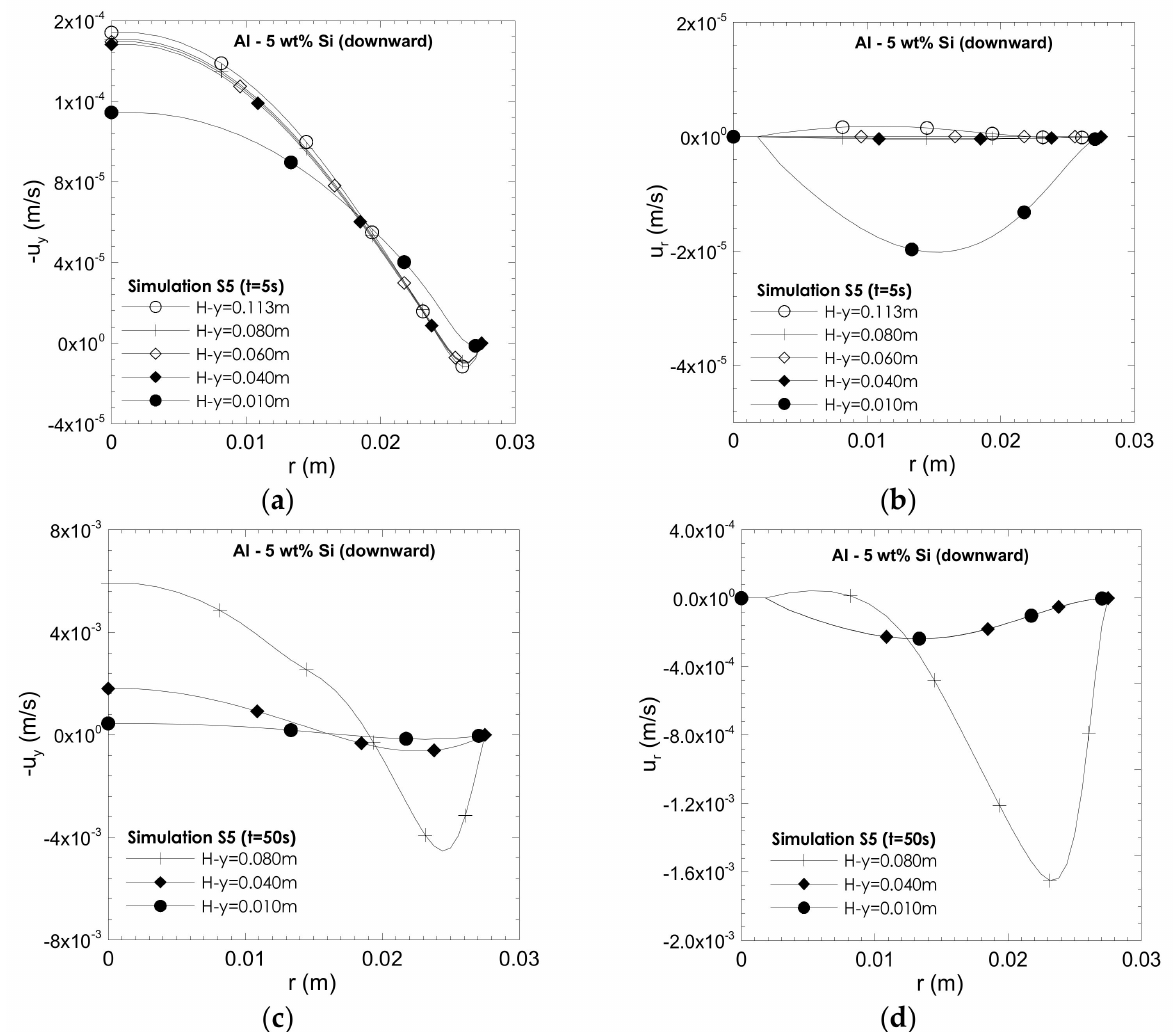
Figure 16. Flow velocity distribution at various locations of y during solidification simulation S5 without effect of ∆ T. ( a ) u y at t = 5 s; ( b ) u r at t = 5 s; ( c ) u y at t = 50 s; ( d ) u r at t = 50